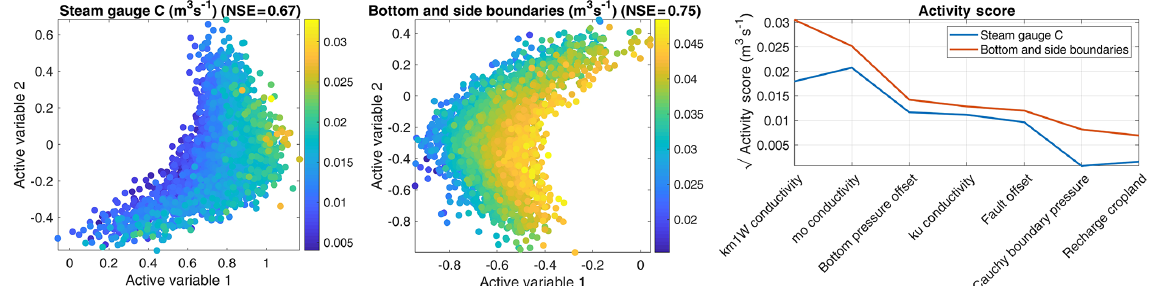
Figure 6. Active subspaces and square root of activity scores for the observations “stream discharge at gauge C” and “net flow across subsurface boundaries”. Please note that the plot is limited to the seven most important